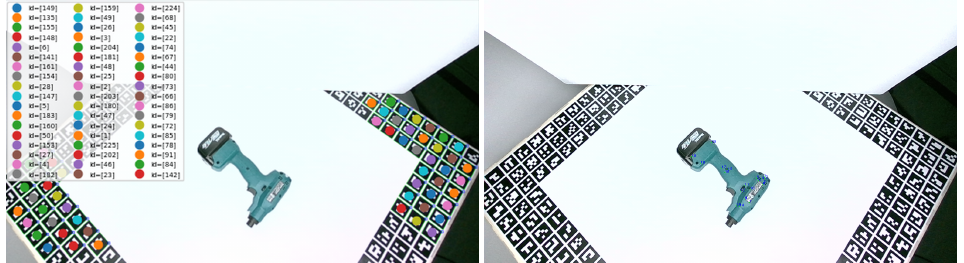
Figure 11. Automatically detected AruCo markers ( left ) and manually selected object points ( right ) on the training images, used to calculate the ground truth object pose.